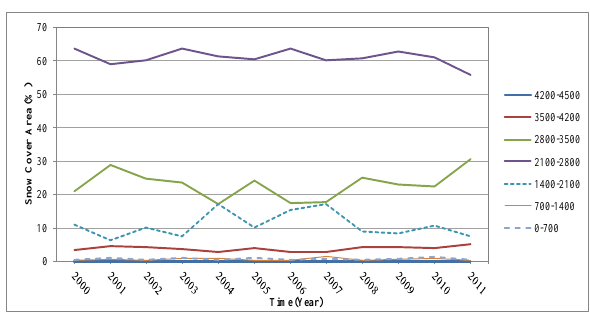
Figure 1. Inter annual variation in SCA for each 700 m of elevation